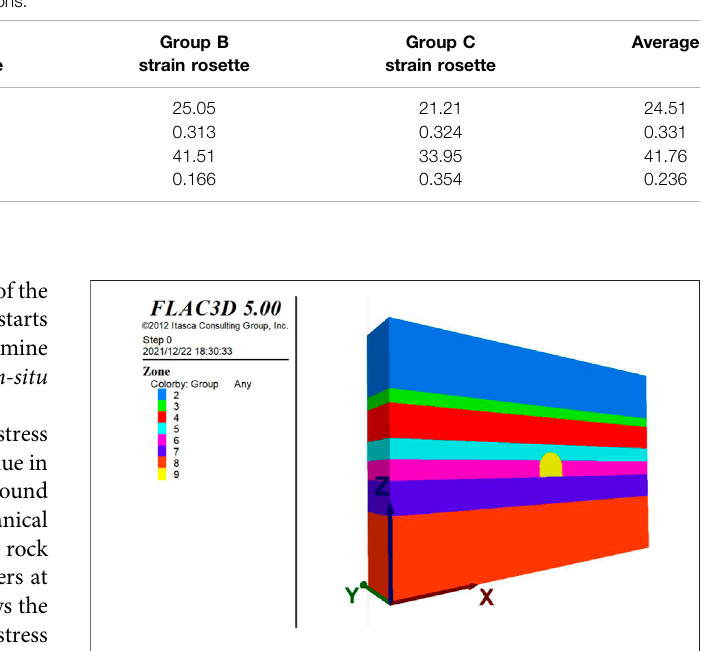
FIGURE 5 | Numerical simulation